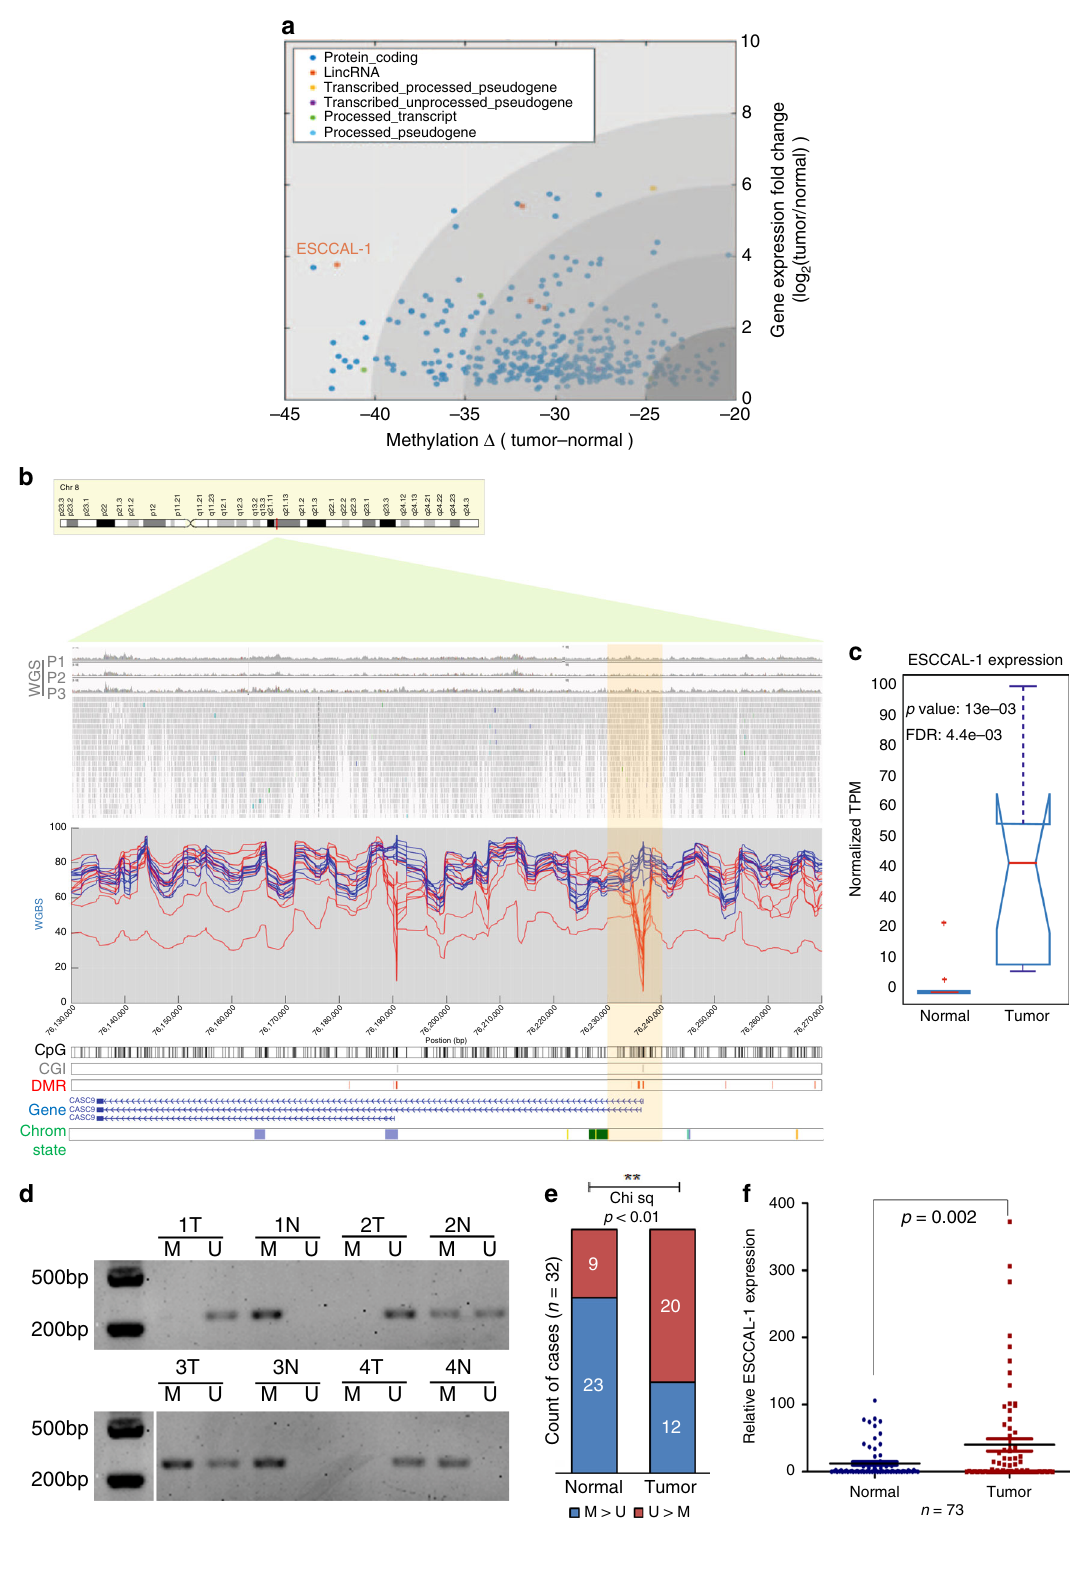
algorithm 70 was used for peak calling. The reads of EZH2 binding on WNT2 promoter region were visualized using Integrative Genomics Viewer (IGV, Broad